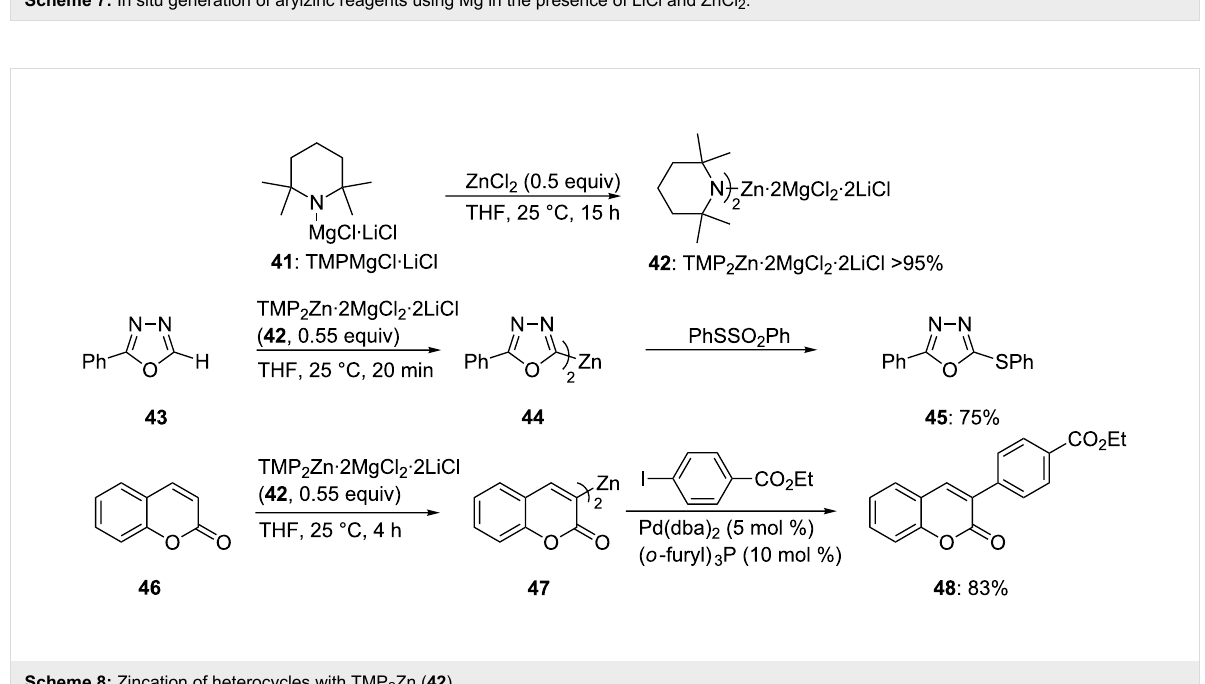
Scheme 7: In situ generation of arylzinc reagents using Mg in the presence of LiCl and ZnCl 2 .